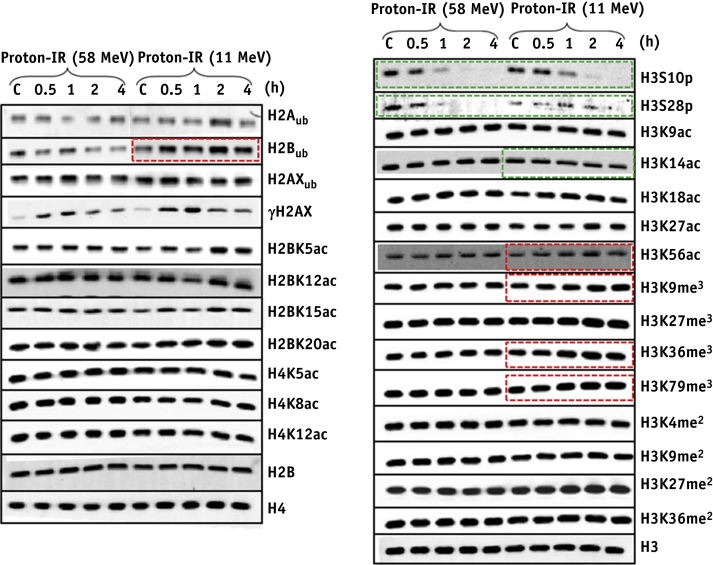
Analysis of histone post-translational modifications (PTMs) in response to proton irradiation. HeLa cells were untreated (designated C) or irradiated with 10 Gy protons at low or high linear energy transfer and harvested at the time points indicated after treatment and purified histones analyzed by immunoblotting. Red boxes indicate increased levels of histone PTMs, whereas green boxes indicate reduced levels. Shown are representative images acquired from at least two independent experiments, and levels of the respective unmodified histone are shown as a loading control. (A color version of this figure is available at www.redjournal.org.)